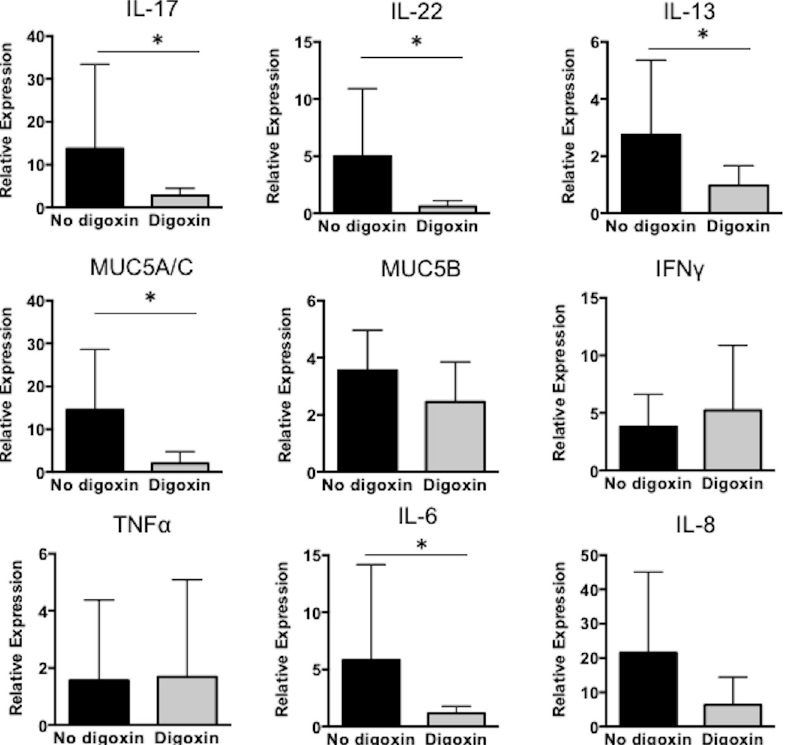
Fig 5. Digoxin treatment alters inflammatory cytokine expression in the lungs during BRSV infection. Lung tissues samples from all calves were analyzed by qPCR for mRNA expression of IL-17, IL-22, IL-13, MUC5A/C, MUC5B, IFN γ , TNF α , IL-6 and IL-8. Results were normalized to the housekeeping gene RPS9, and expressed relative to the uninfected, untreated control calves. Data represent means ± SEM. � p < 0.05 as determined by Kruskal-Wallis test, followed by Dunn’s multiple comparisons